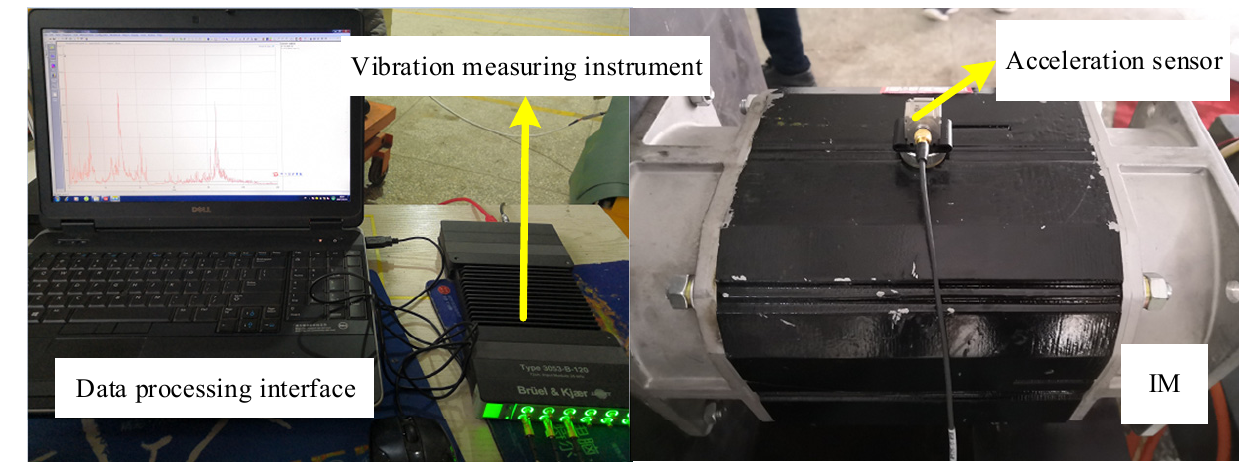
( c ) Figure 24. Experimental results under pulse time compensation. ( a ) i as ; ( b ) FFT; ( c ) Power spectral density. ( c ) Figure 25. Experimental results under 6th harmonic controller. ( a ) i as ; ( b ) FFT; and ( c ) power spectral density.